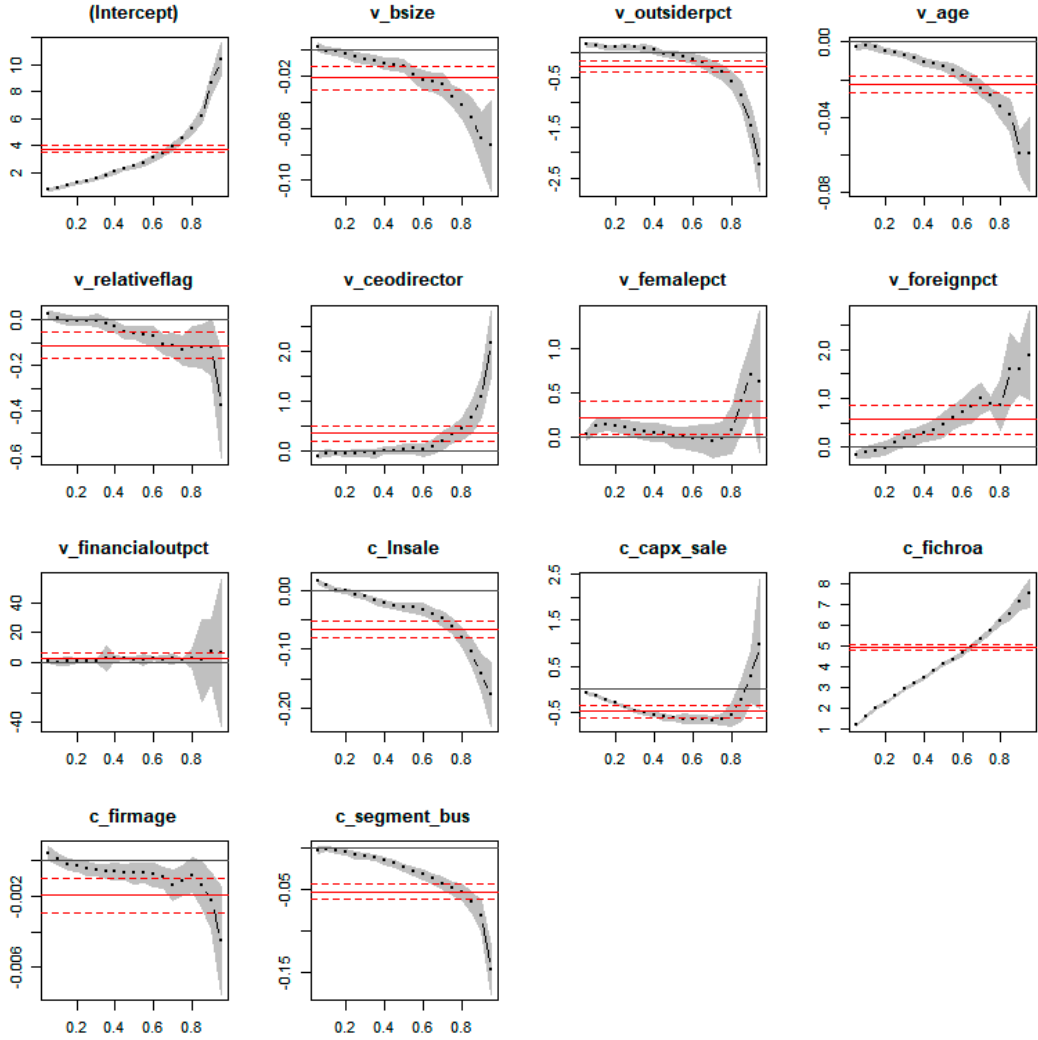
= seq (0.05, 0.95, by =